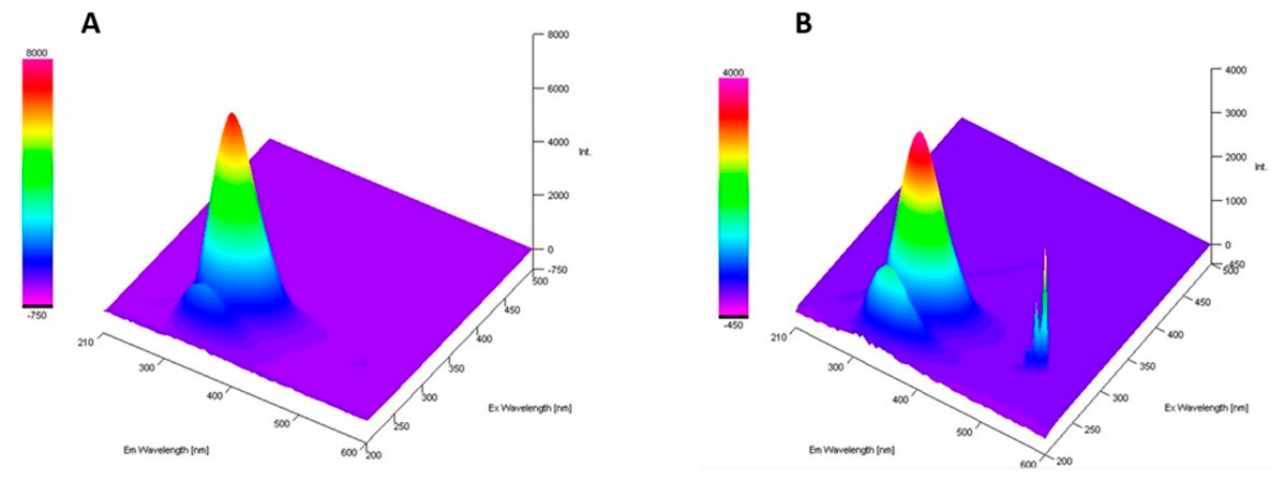
Figure 6. The 3D-spectra fluorescence of ( A ) native bLTF and ( B ) AgLTF1200